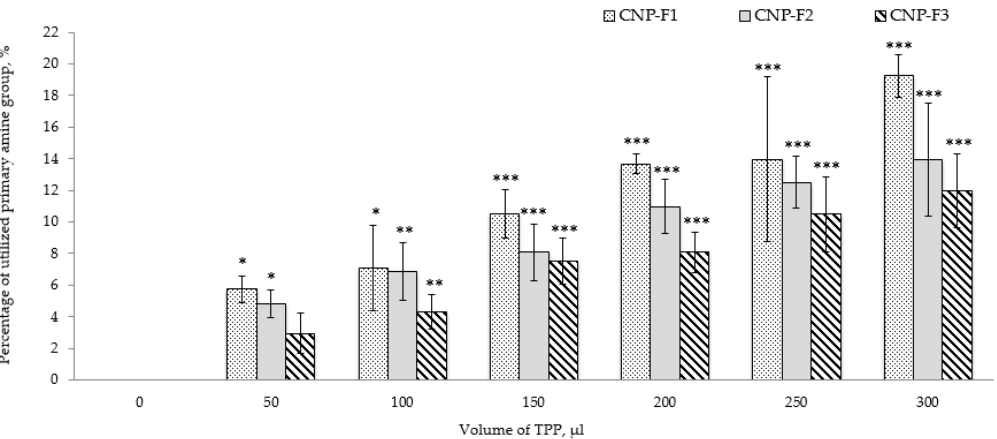
Figure 1. Influence of TPP volume on percentage of utilized amine group in combined graph bar CNP-F1, CNP-F2, and CNP-F3. The percentage of utilized primary amine (-NH 3 + ) groups increases with TPP addition. The figure suggests that with increasing TPP volume, more phosphate ions, -PO 43 − groups were available to readily interact with -NH 3 + groups to form CNP, hence reducing the availability of free -NH 3 + groups. Error bars represent the standard deviation (SD) of three independent replicates of the experiment. * shows degree of significant difference, P < 0.0001 compared to control, 0 µL of TPP volume.